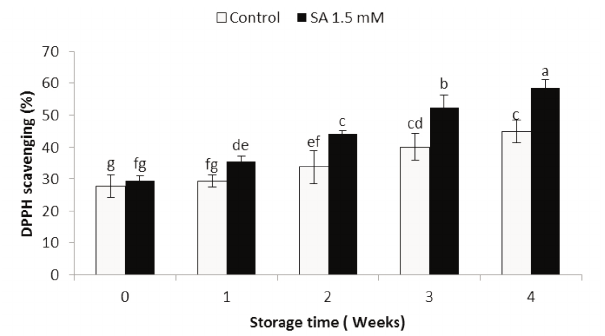
3).Fig. 6 - DPPH scavenging capacity of peach fruits treated with preharvest SA at 1.5 mM stored at 1 ± 0.5°C for up to 28 days. Data shown are mean±standard deviation of three replicate (n = 3).